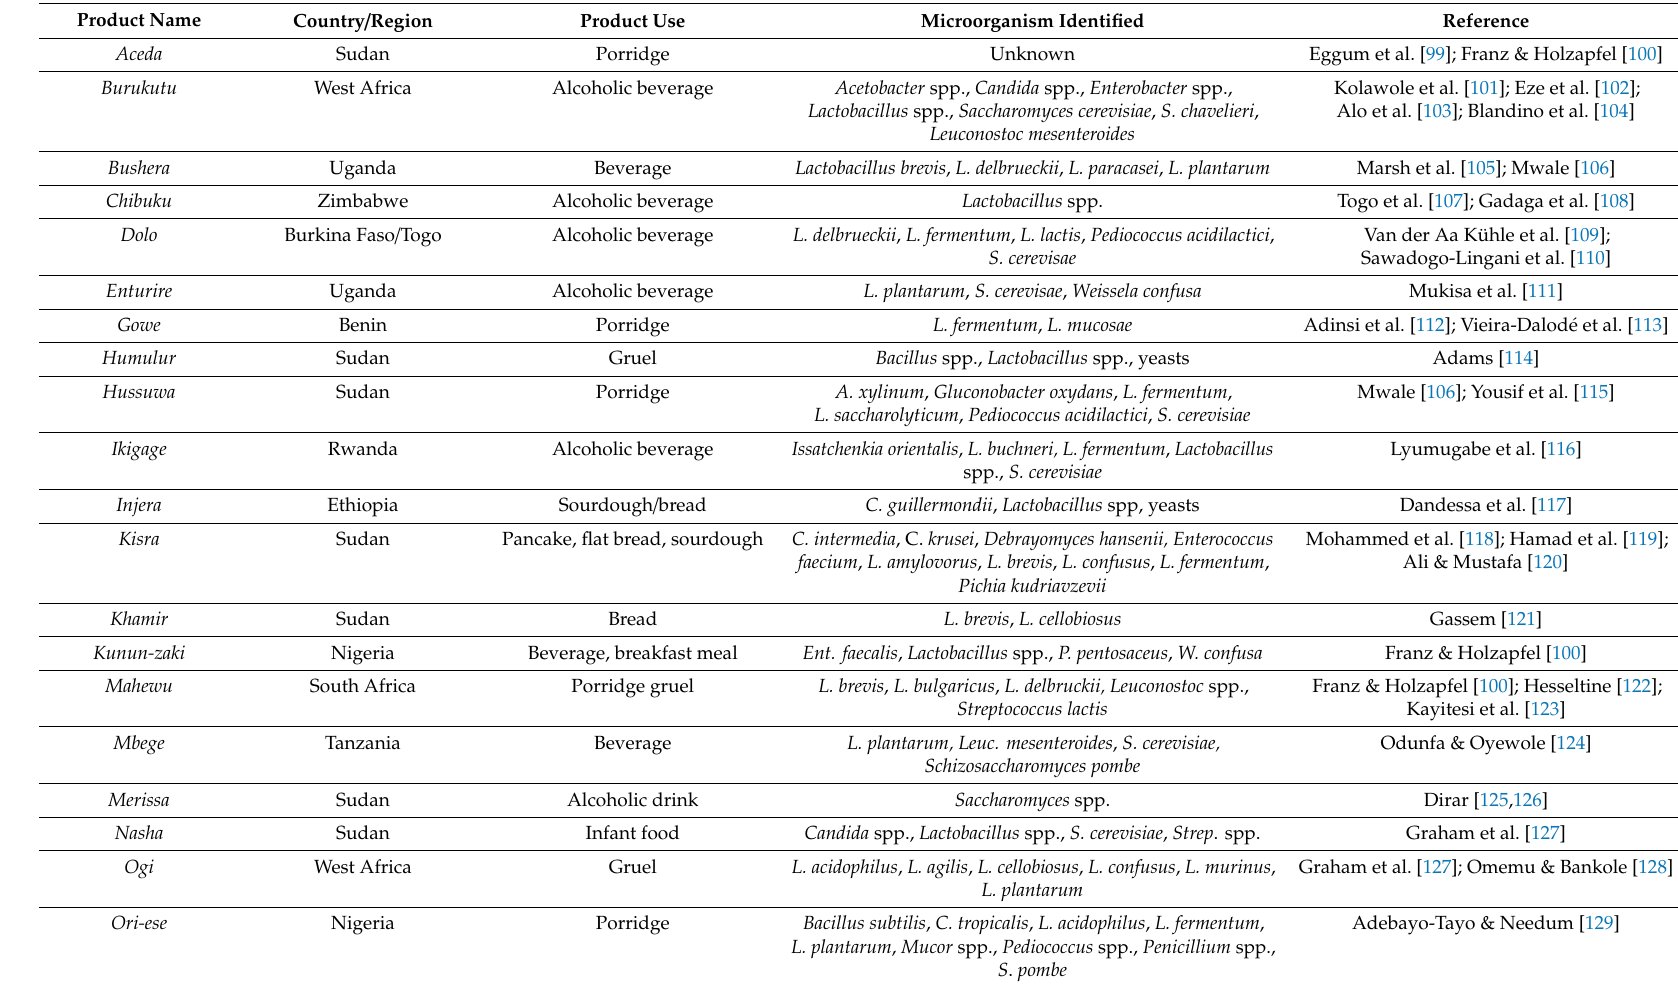
Table 5. Some African sorghum-based fermented food products and microorganisms associated with